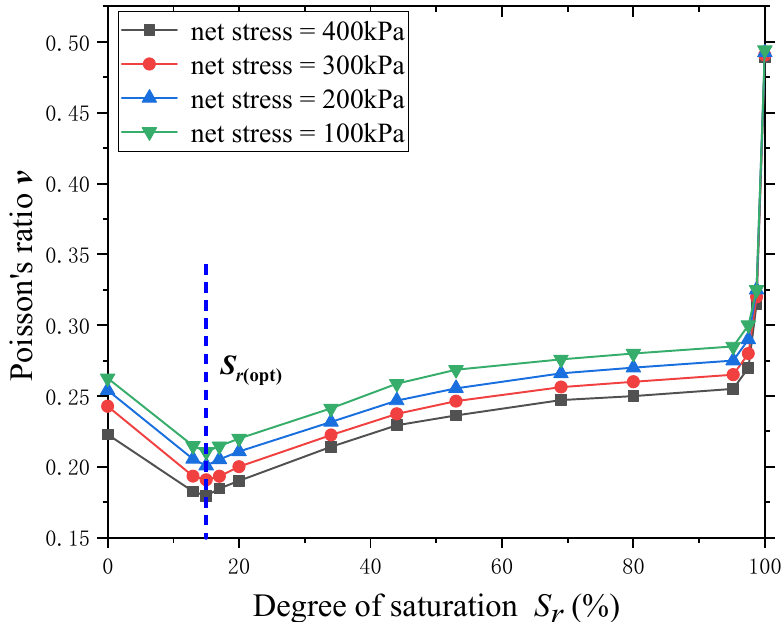
Figure 6. Poisson’s ratio variation curve with saturation.